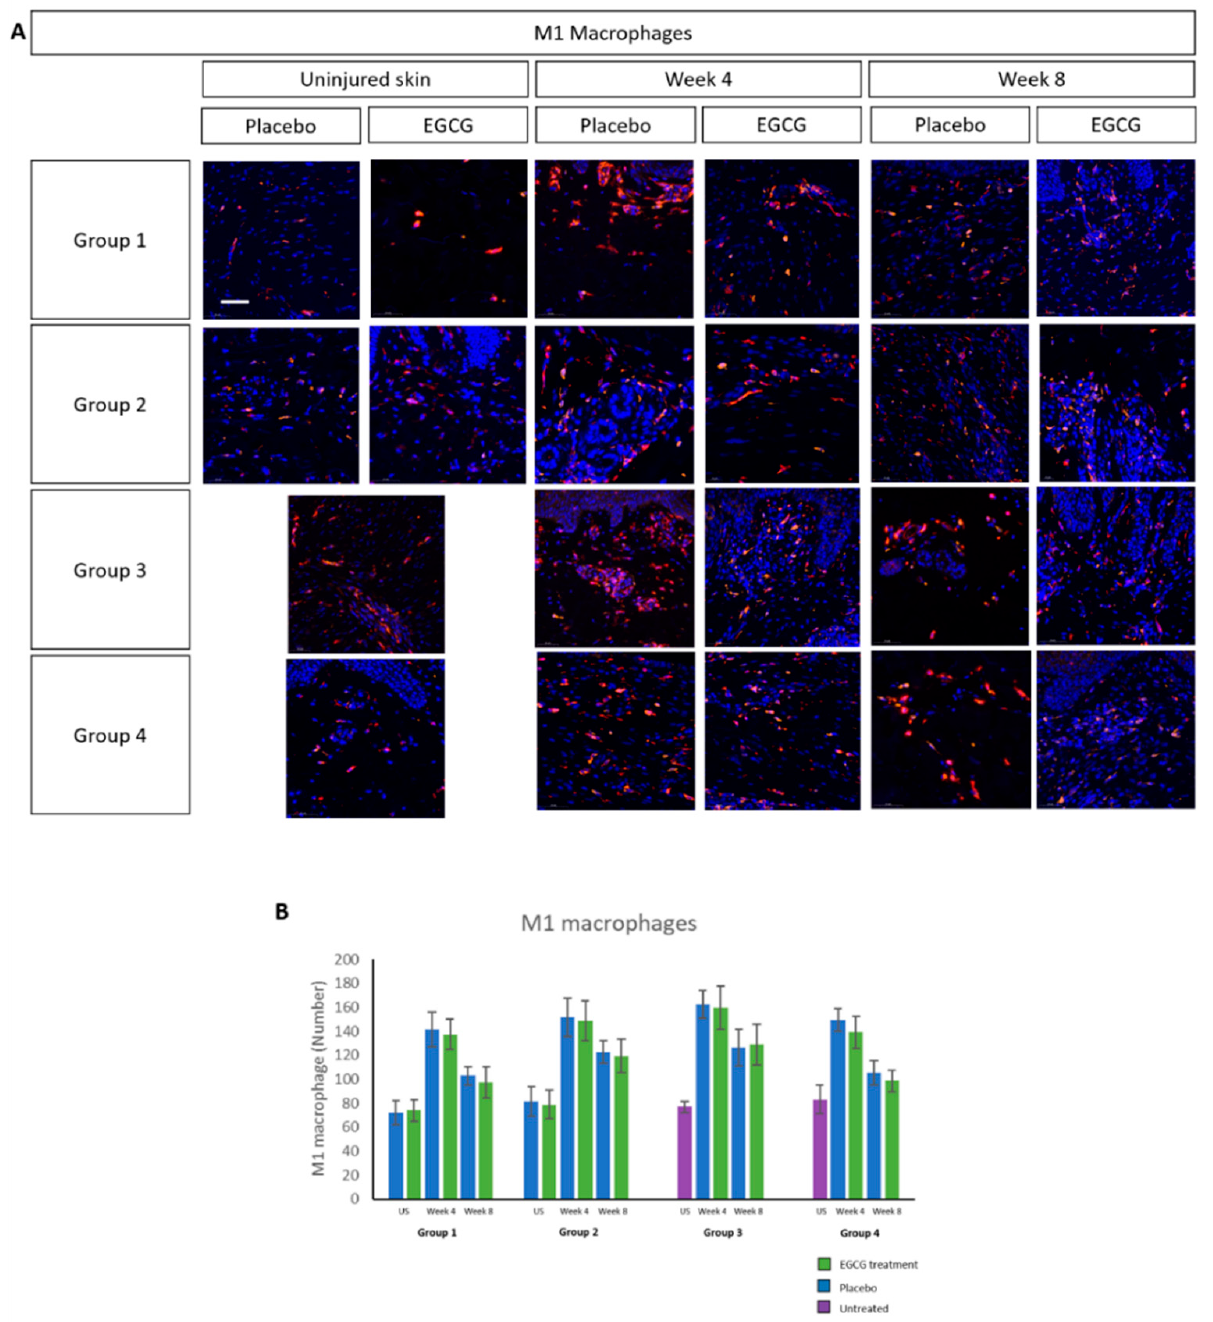
Figure 9. Immune cell analysis of total number of M1 macrophages in whole tissue. ( A ) M1 macrophage analysis demonstrated higher expression at week 4 compared to uninjured skin, reaching levels similar to uninjured skin by week 8 in treated and placebo samples in all groups. ( B ) There were no significant differences seen in EGCG samples compared to placebo samples or between the groups. Scale bars = 50 μ m.